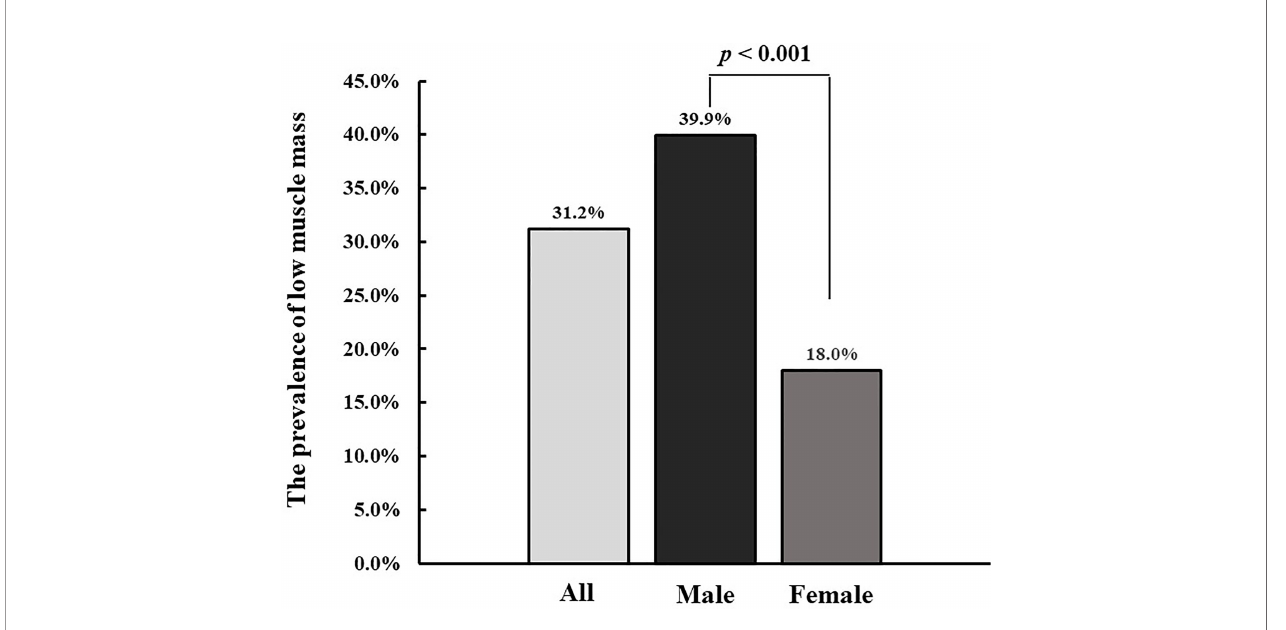
FIGURE 1 | The prevalence of low muscle mass among all patients, male and female, male vs